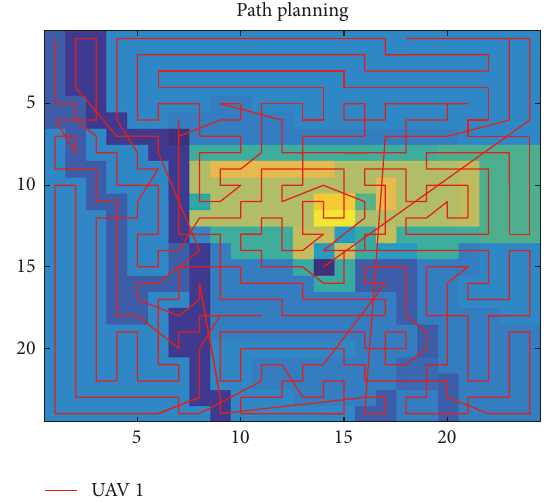
Figure 5: La Palma attraction path planning.